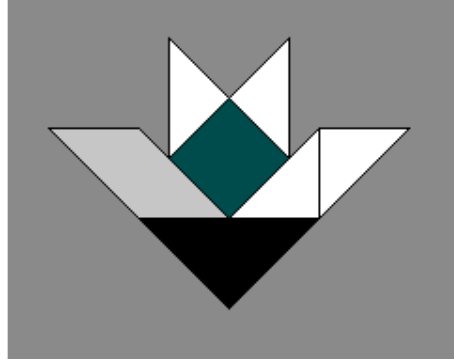
Figure 3: Solved tangram -